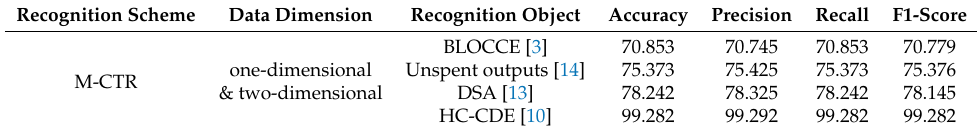
Table 2. Results of the M-CTR